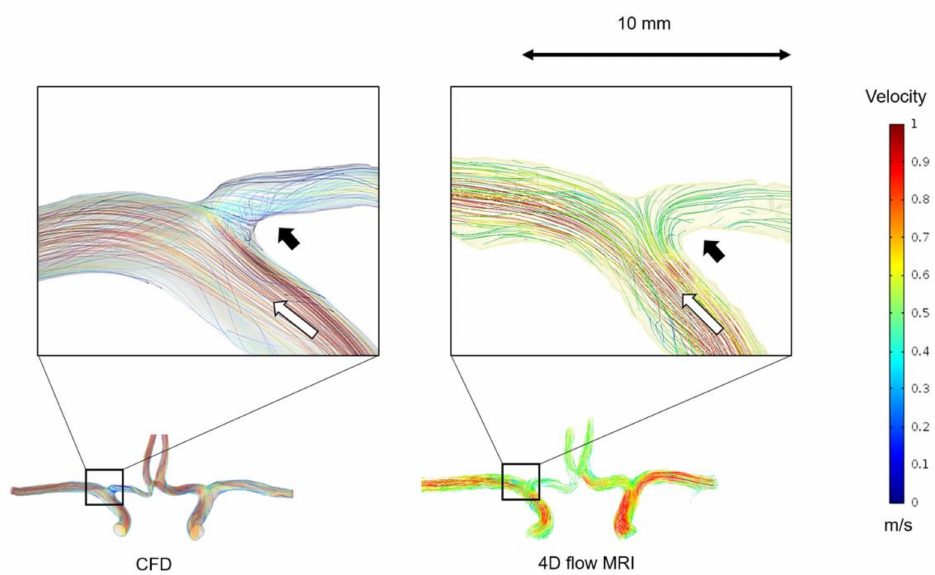
Figure 2. 3D blood flow characteristics of the cerebral arteries obtained from CFD and 4D flow MRI. The major flow structures (white arrow) and the recirculation regions (black arrow) observed in the CFD coincided with those in 4D flow MRI. The same velocity scale bar with color was applied for all the images ranging from 0–1